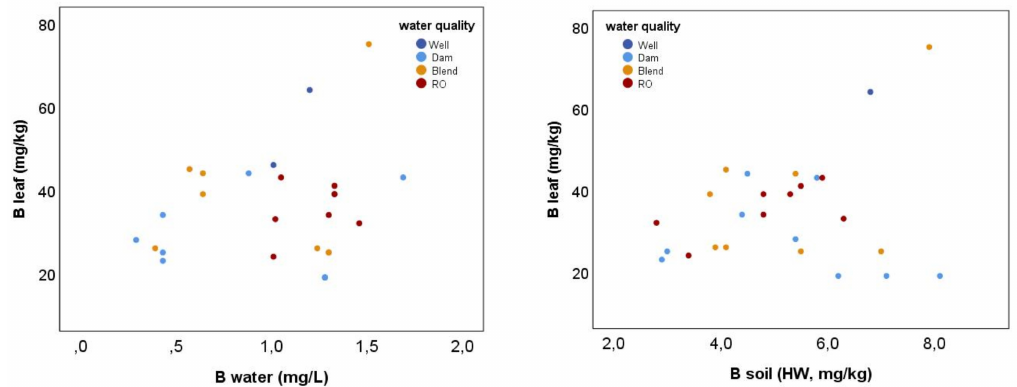
Figure 3. a (left) Relationship between B leaf (mg / kg) contents and B in water (mg / L) and b (right) B leaf contents (mg / kg) and B in soil (HWSB, mg / kg) irrigated with the four water origins.